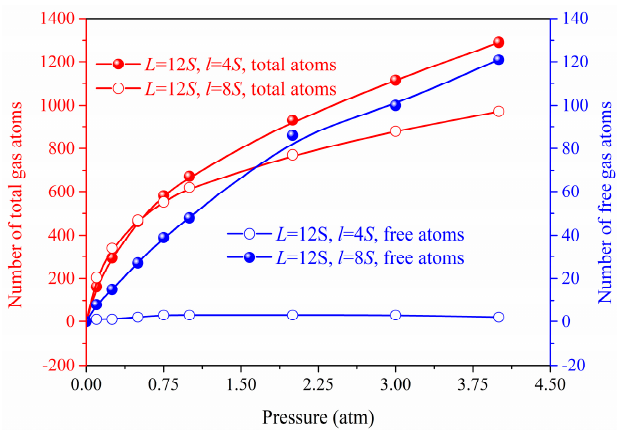
Figure 4. Total and free gas atoms number in the nanoporous systems.